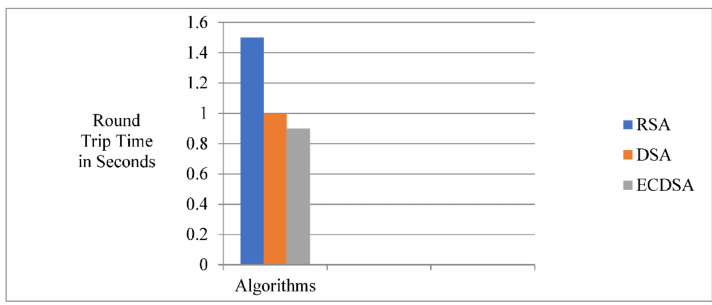
Figure 17. Round Trip Time of RSA, DSA and